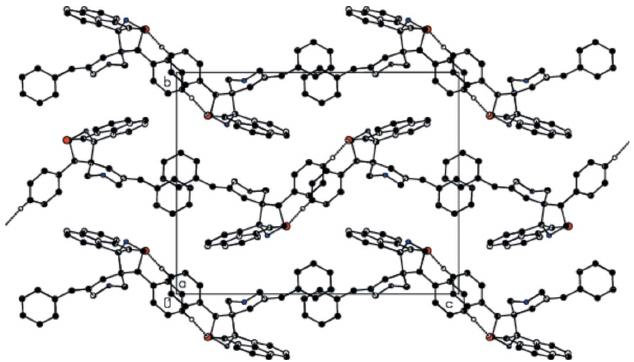
Figure 4 Perspective view along the a axis showing the weak C16—H16 (cid:2)(cid:2)(cid:2) O2 intermolecular interactions between centrosymmetric pairs of molecules in (I) and (II). Non-participating H atoms, methyl C atoms and Cl atoms have been omitted for